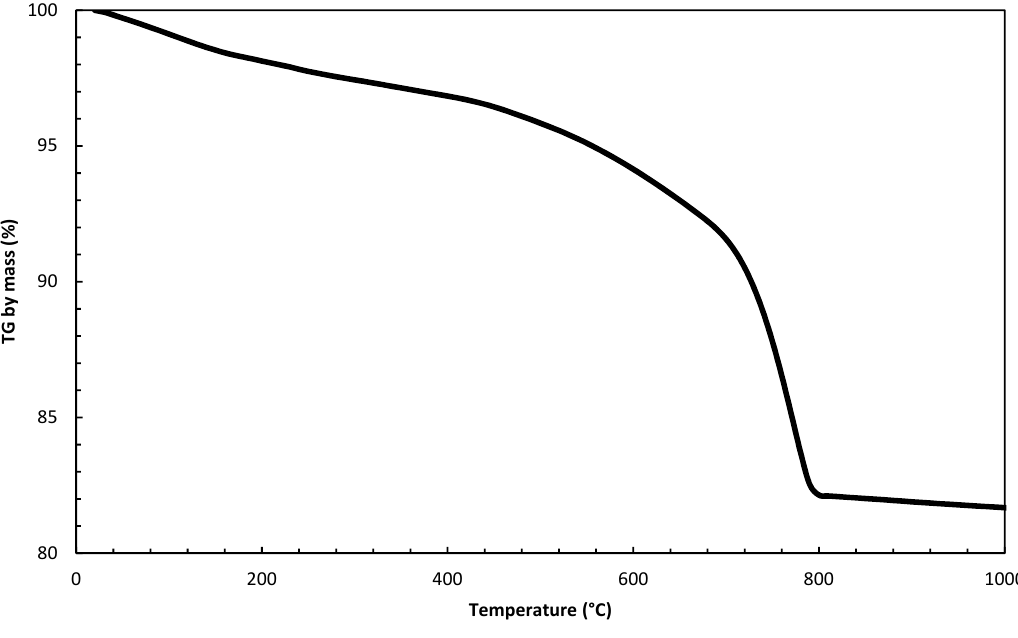
Figure 14. Thermal degradation curve showing the losses in each step with a rate of 10 °C/min (sample S-004).